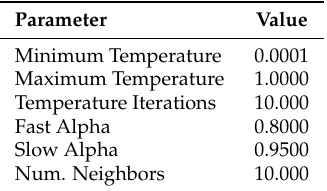
Table 5. Input parameters for the Hybrid Simulated